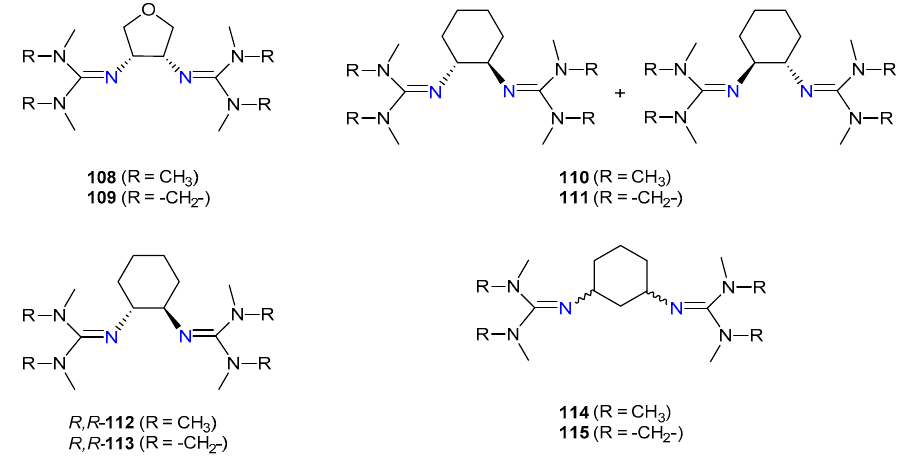
Figure 19. Guanidine-derived ligands 108–115 [73].